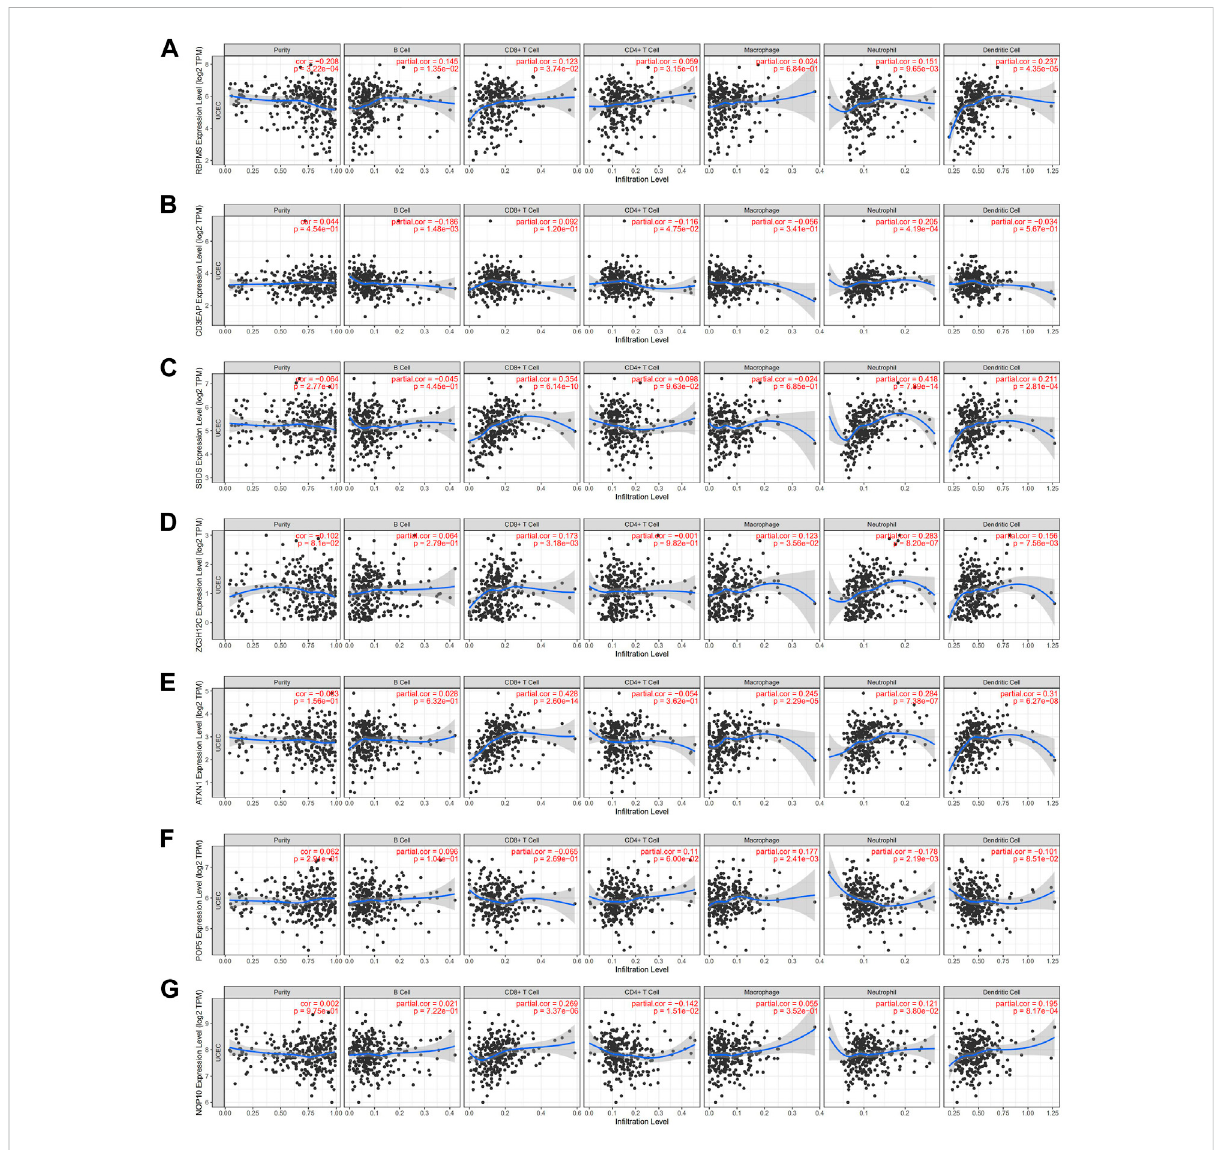
FIGURE 9 Relationships between expression of seven hub RBPs and tumor immune in fifi ltrations (A) RBPMS, (B) CE3EAP, (C) SBDS, (D) ZC3H12C, (E) ATXN1, (F) POP5, (G) NOP10.